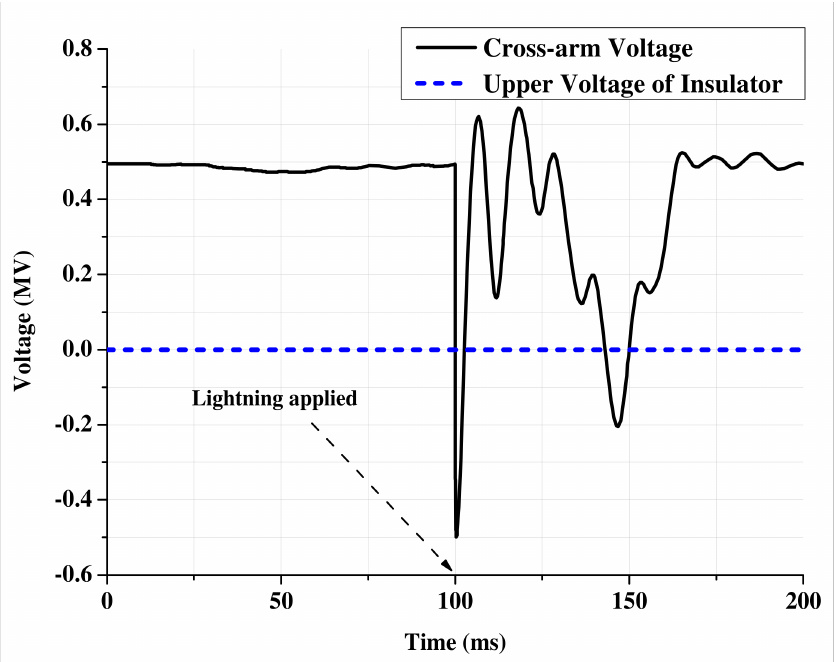
Figure 20. Voltage at tower cross-arm point and upper point of insulator in the case of shielding failure at 100 kA.